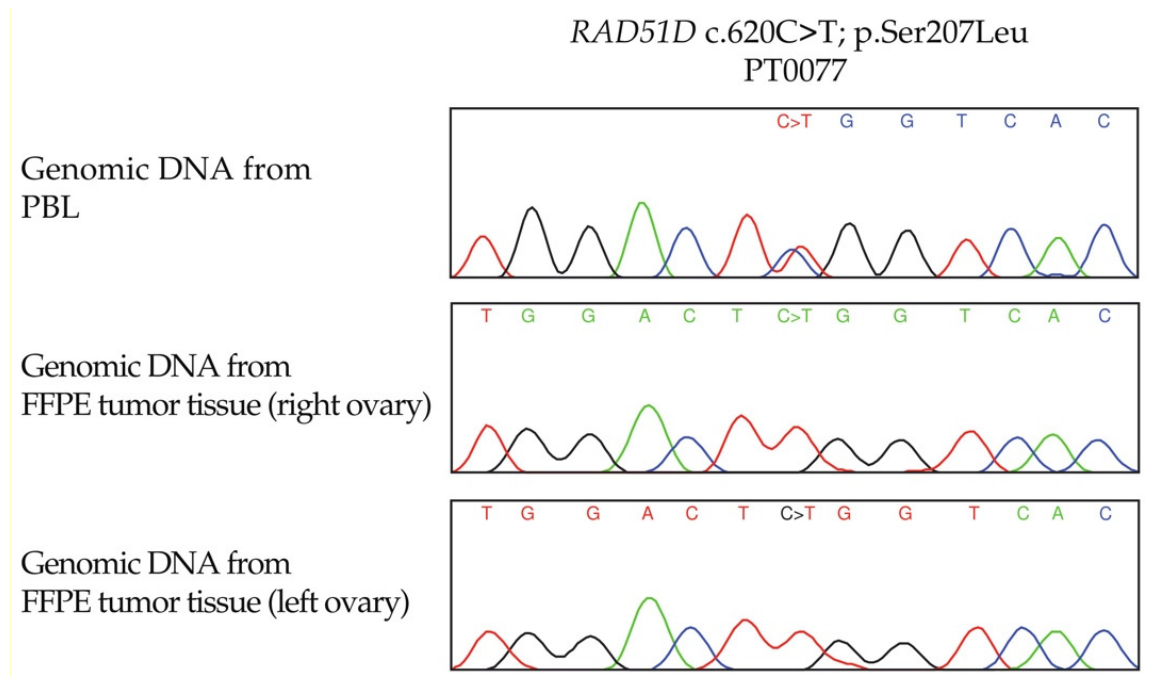
Figure 2. Loss of heterozygosity (LOH) analysis of a RAD51D c.620C>T carrier. Sanger sequencing chromatograms showing evidence of a complete loss of the wild-type variant in genomic DNA from formalin-fixed paraffin embedded (FFPE) tumour tissues from both ovaries.